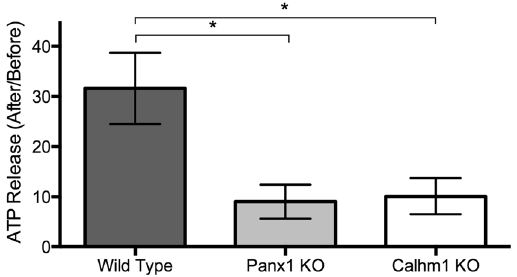
Figure 1. Apical ATP release 15 seconds after a 55-mmHg air puff in nasal septal epithelial cell cultures from Calhm1 knockout, Panx1 knockout, and wild-type mice. Bars are means ± SE of 5 cultures each. * p < 0.05, ANOVA with Dunnett’s multiple comparisons